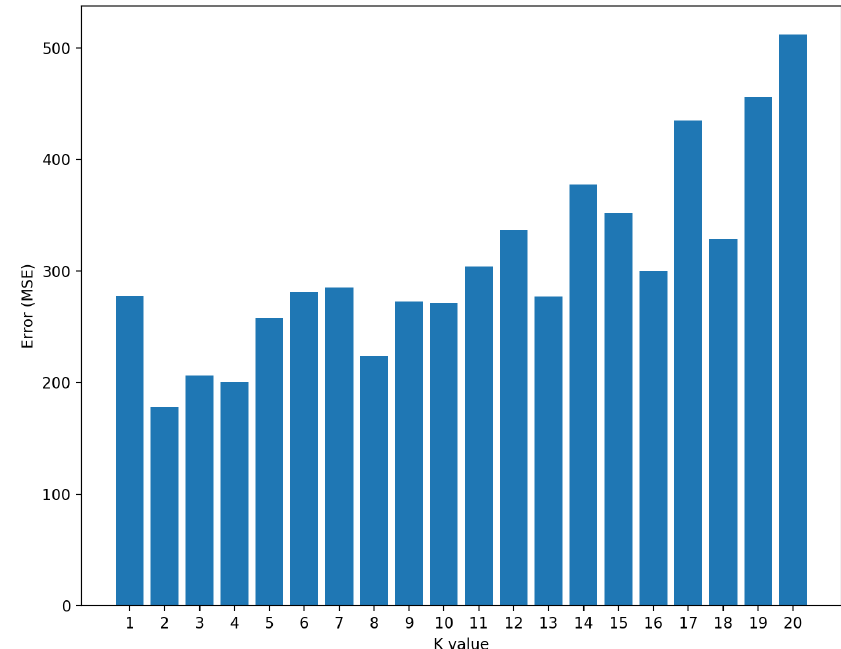
Figure 9. Estimated signal prediction error with different K